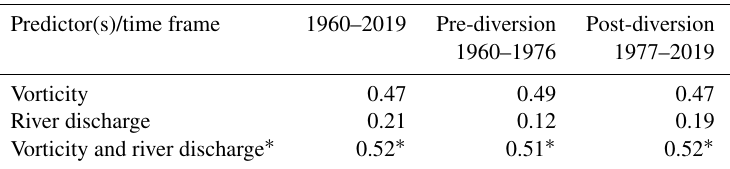
Table 3. Correlations ( R ) of monthly-mean atmospheric vorticity and/or Churchill River discharge against sea-level anomalies in western Hudson Bay for the ice-covered period